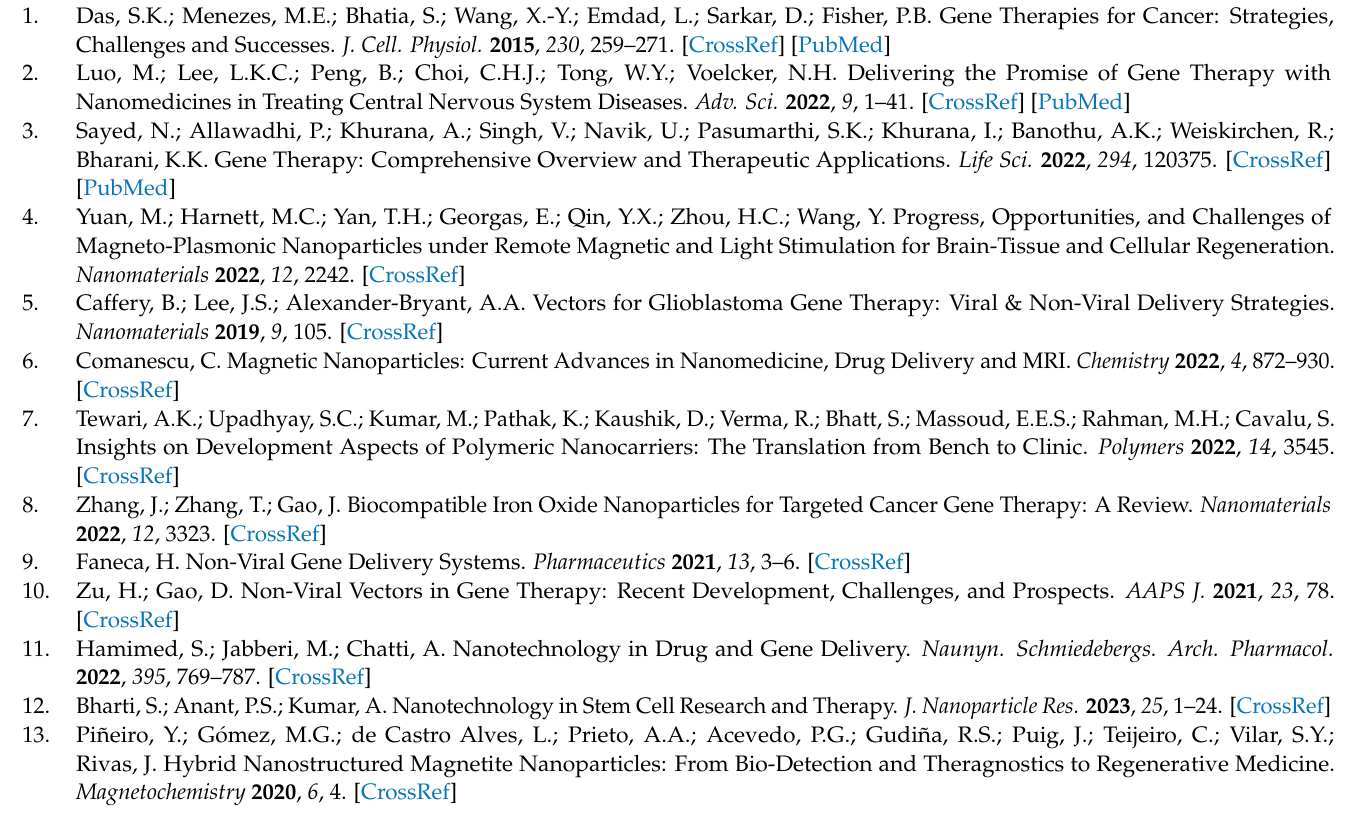
Figure S3. Dynamic Light Scattering measurements of MSNs: Size Distributions by Number (a) and Zeta Potential Distributions (b). Figure S4. Dynamic Light Scattering measurements Figure S5. Hysteresis loops measured on SPIONs@PDA at room